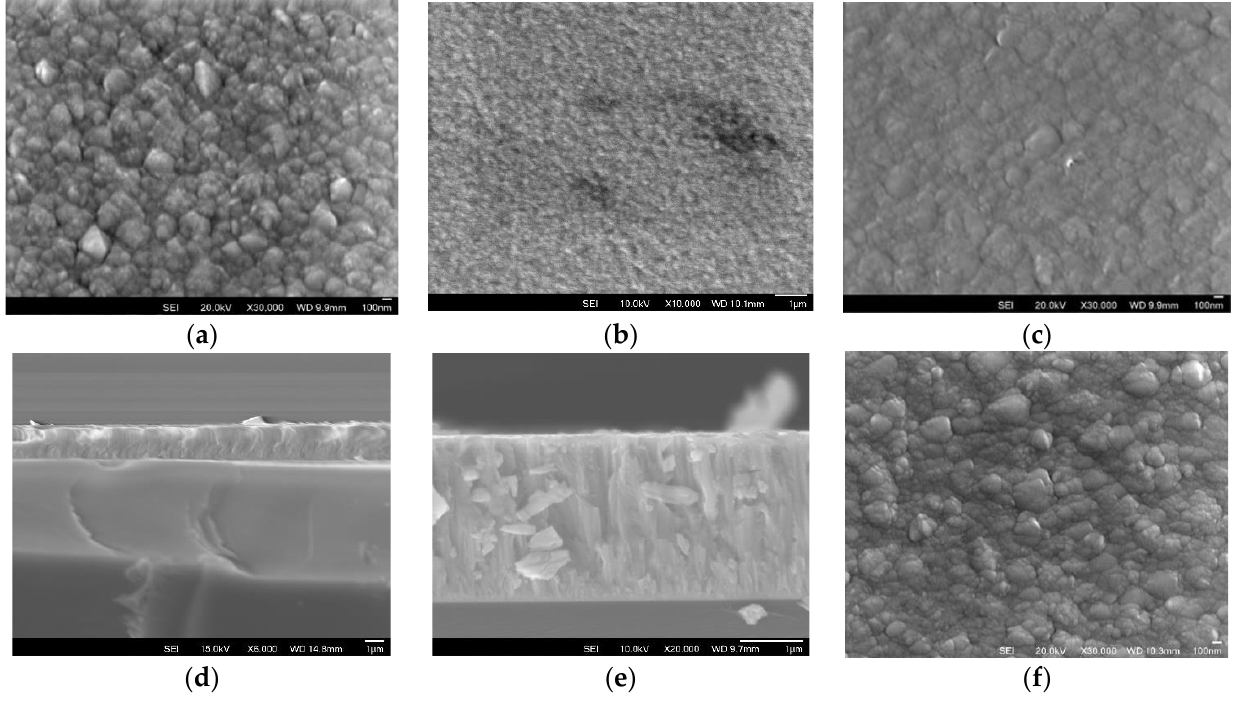
Figure 3. P-type BiSb 2 Te 3 thin film deposited on silicon wafer: ( a , d ) P4, ( b , e ) P45, ( c ) P5, and ( f )